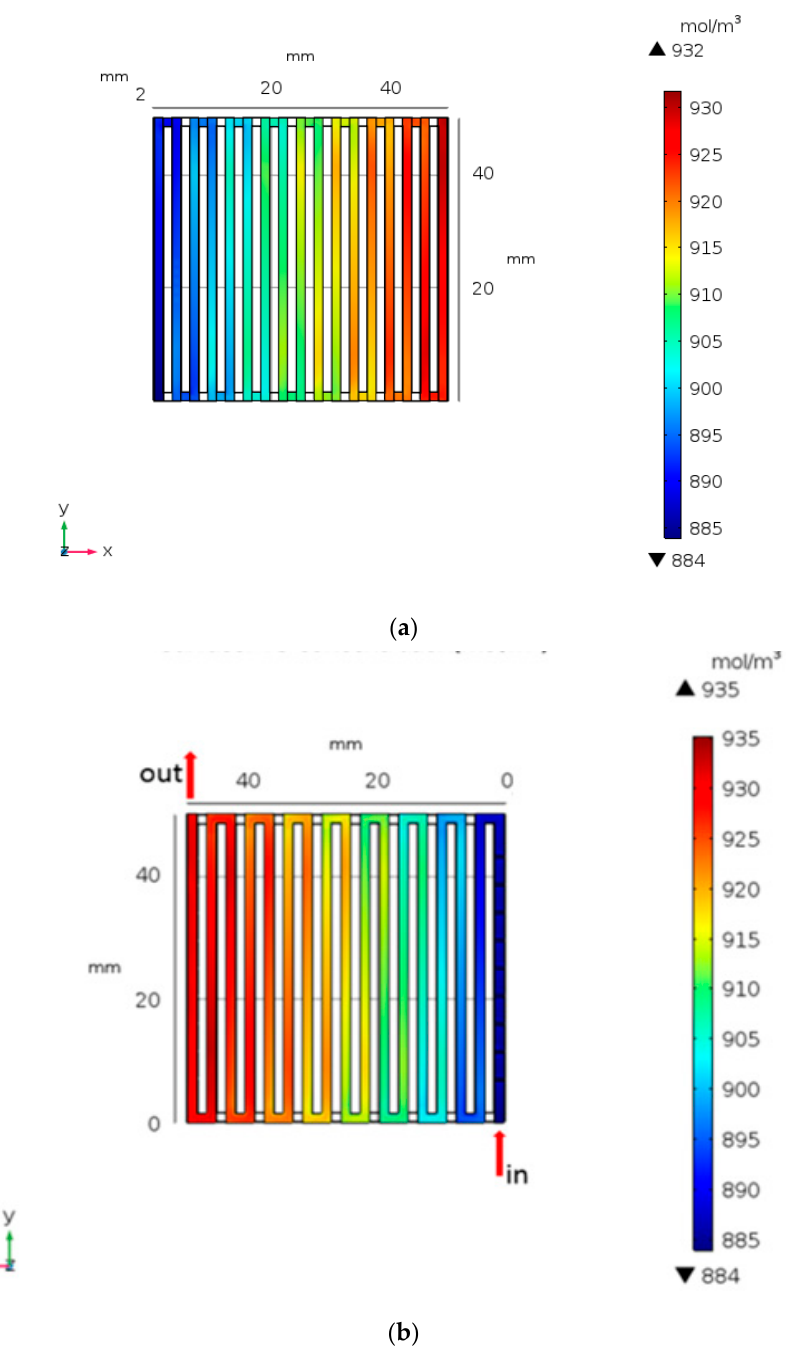
Figure 7. Concentration distribution for 𝑉 (cid:2871)(cid:2878) of ( a ) smooth and ( b ) setting baffle height at 0.9 h from numerical